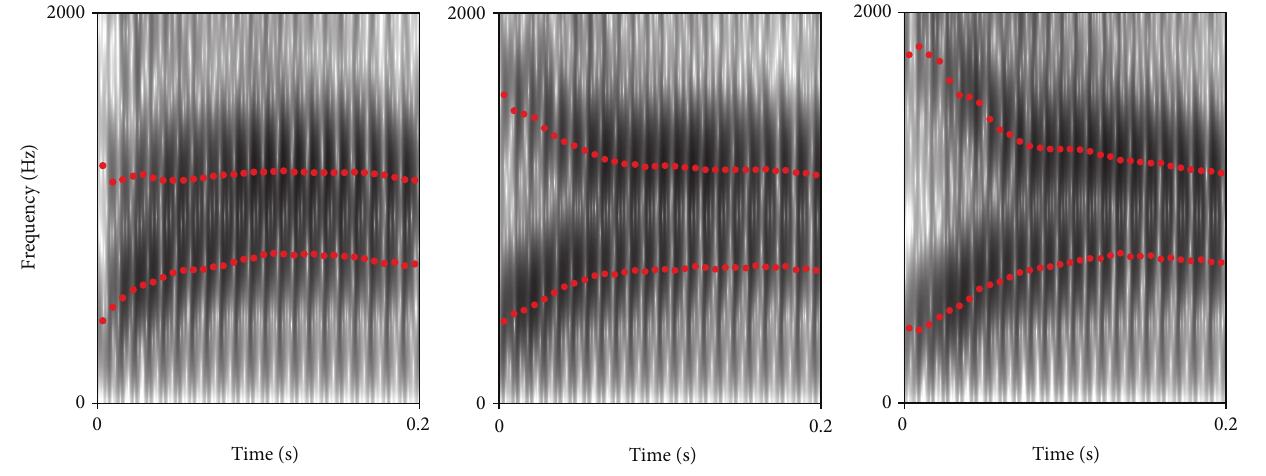
Figure 2: Spectrograms for voiced stop consonants /ba, da, and ga/ with F1 and F2 labelled.